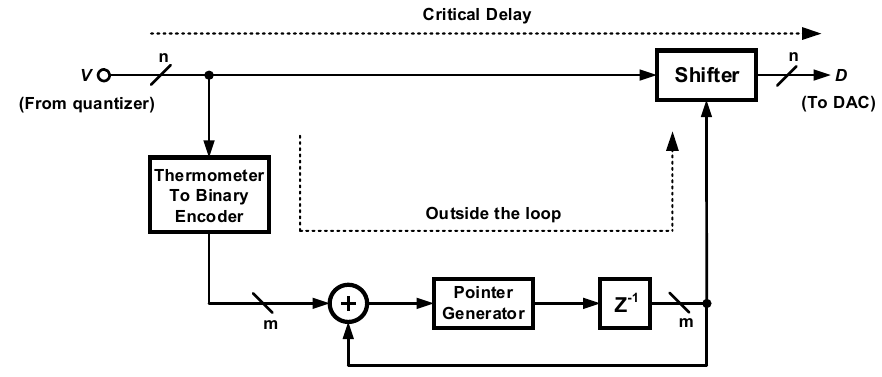
Figure 1. Block diagram of dynamic element matching (DEM) [1].